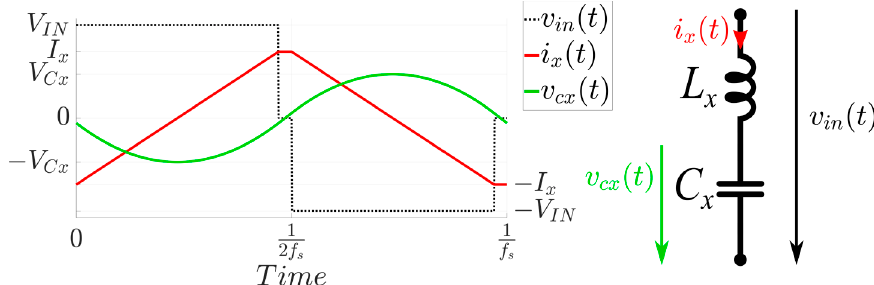
Figure 18. Auxiliary circuit current and voltage and auxiliary capacitor voltage ripple.